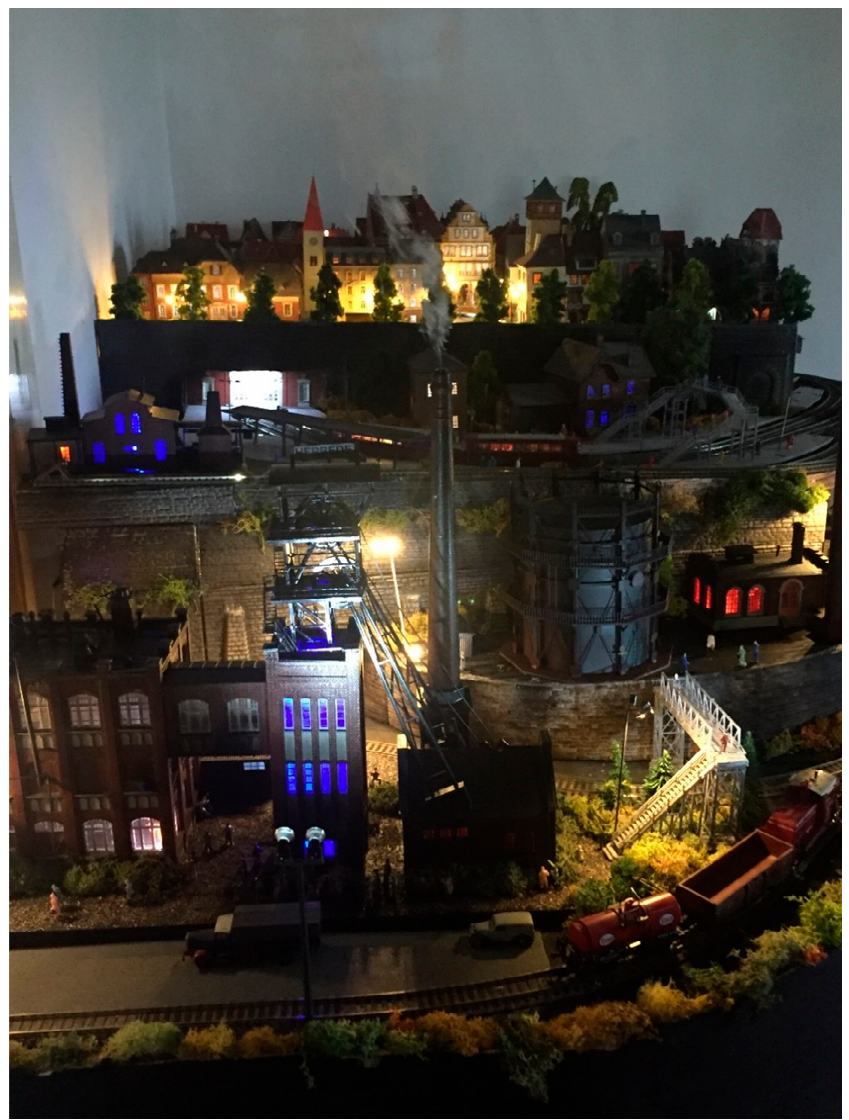
Figure 1. Detail of a model railway landscape, characterized by the builder’s preference for old industrial plants; at the same time, the industrial plants legitimize extensive goods operation, the urban settlement in the background is used for passenger service, the reproduction of the relief also serves to conceal the tracks inside the mountain, and the reproduction of buildings and vehicles links the plant to the early 1970s/late 1980s (created by author).